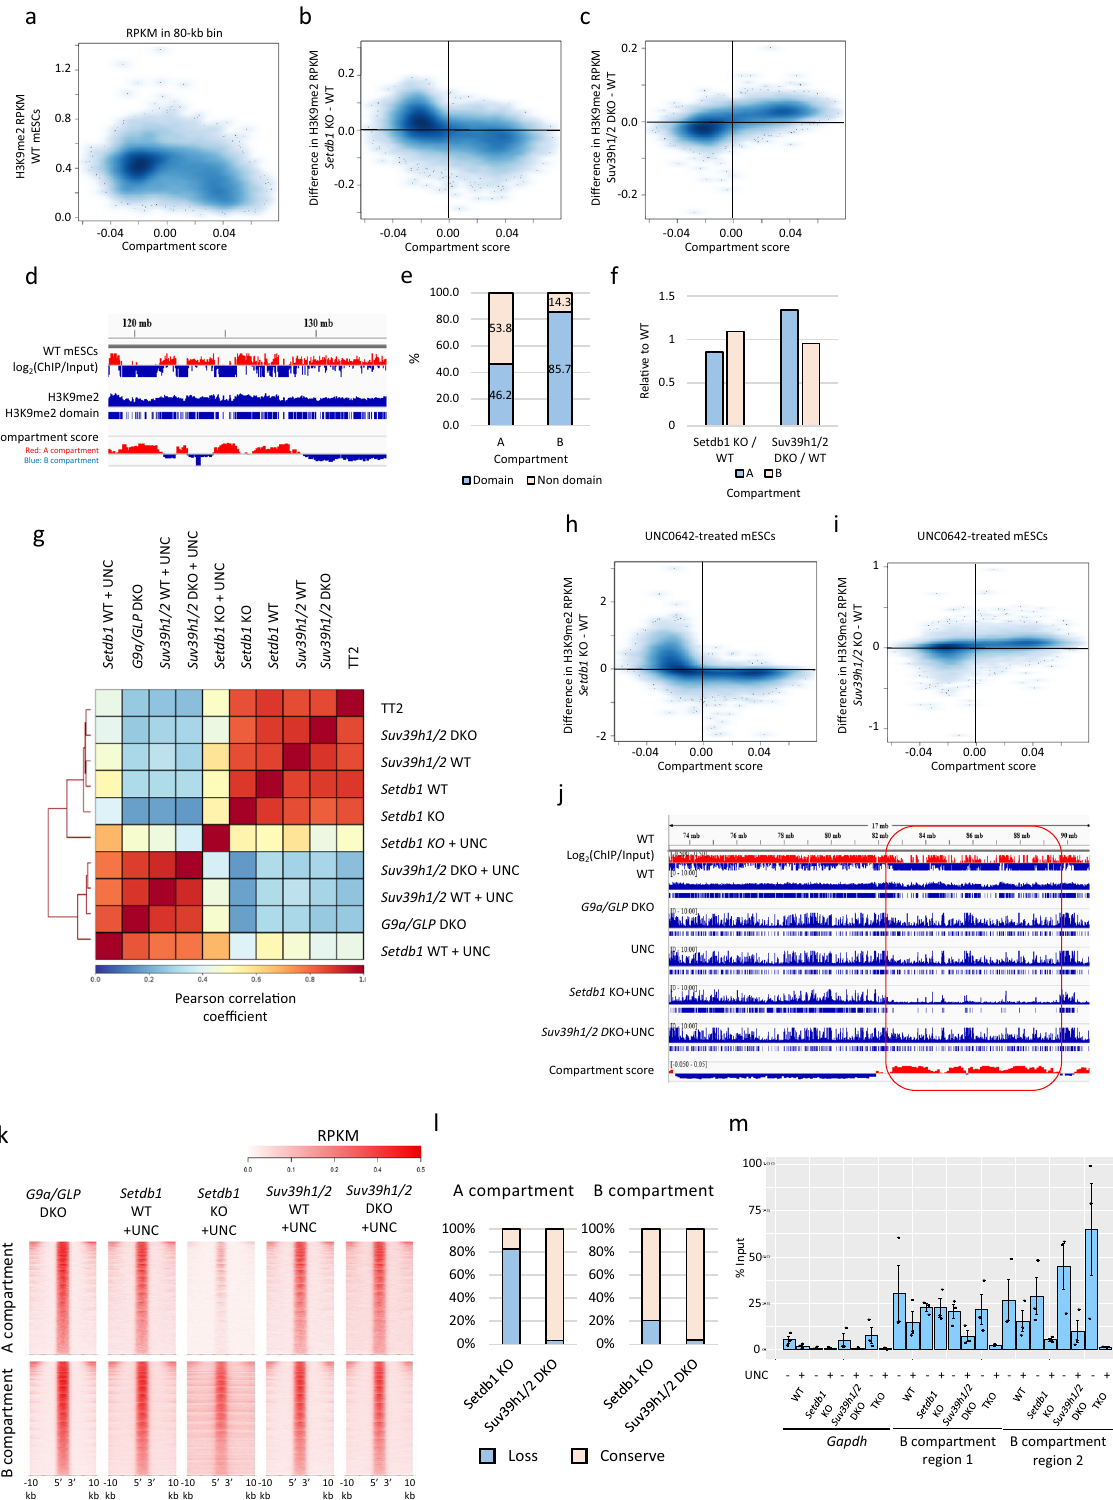
score0.00 Compartment